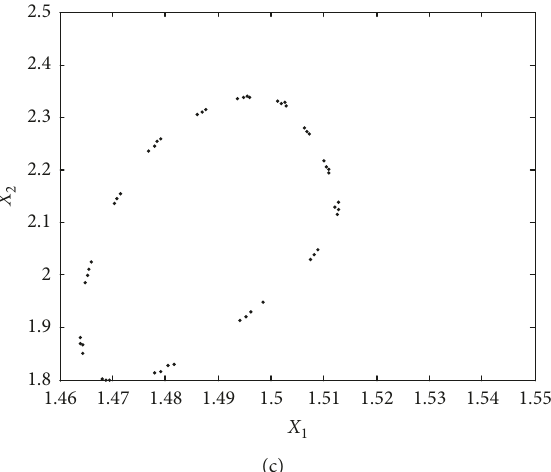
Figure 6: The quasi-periodic motion ( Ω � 2, ω � 1, c � 0.1, r � 0.5, p � 10, c diagrams. (c) Poincar ´ e maps.